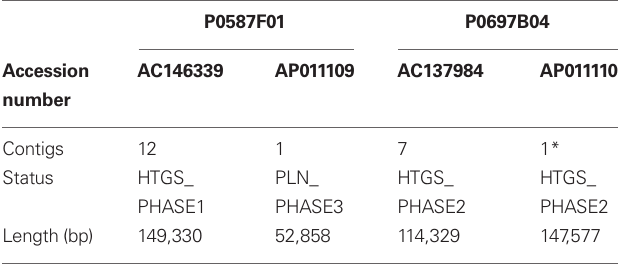
Table 1 | Improvement of the sequences of PAC clones.